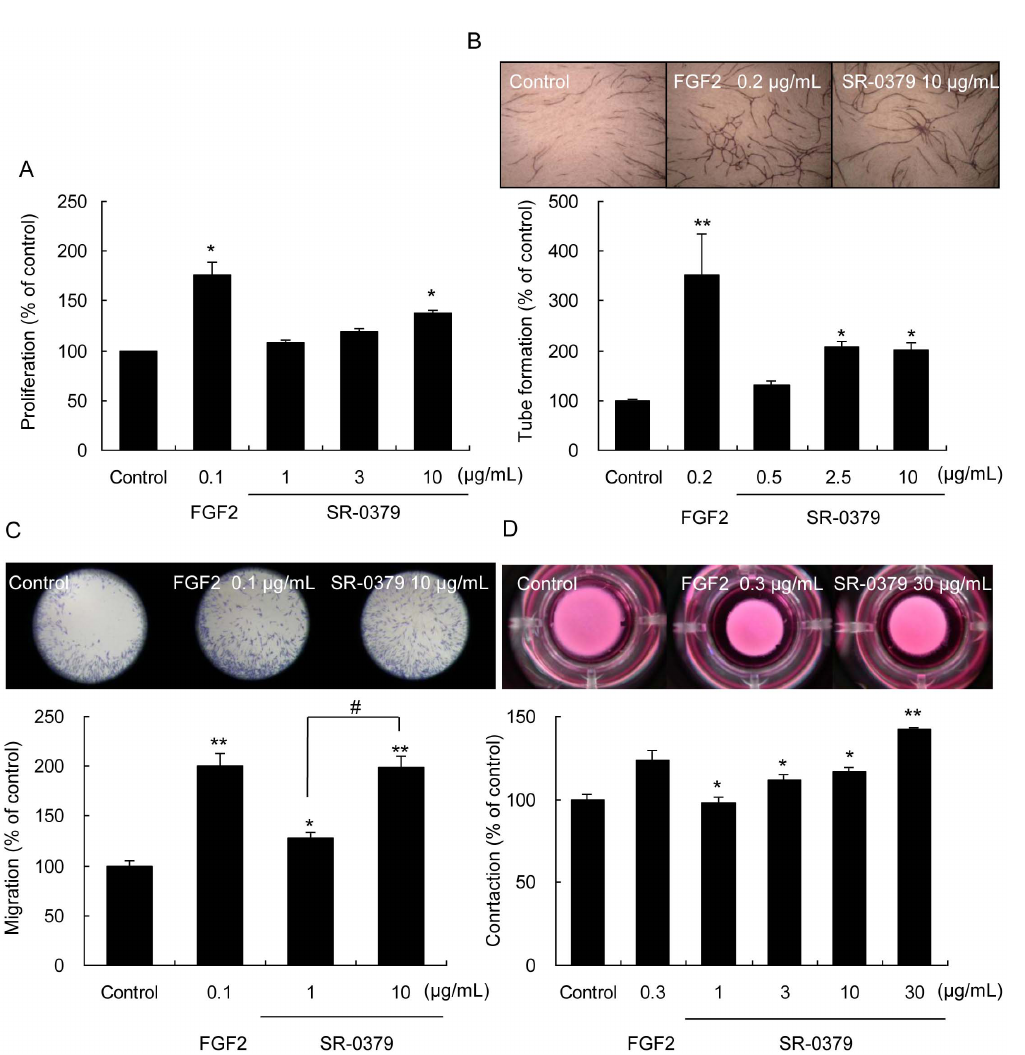
Figure 2. Cellular function of SR-0379. A) Effect of SR-0379 on NHDFs proliferation. NHDFs were treated with SR-0379 (1, 3 and 10 m g/ml) or FGF2 (0.1 m g/ml). N=4 per group. *P , 0.05 vs. control. B) The upper panel shows representative pictures of tube formation in a co-culture of HUVECs and NHDFs (Control, FGF2: 0.2 m g/ml) and SR-0379 (10 m g/ml). The lower panel shows the effects of SR-0379 on tube formation in a co-culture of HUVECs and NHDFs. N=5 per group. *P , 0.05, **P , 0.01 vs. control. C) The upper panel shows representative pictures of the migration induced by FGF2 (0.1 m g/ml) and SR-0379 (10 m g/ml). The lower panel shows the effects of FGF2 (0.1 m g/ml) and SR-0379 (1 and 10 m g/ml) on migration. N=4 per group. *P , 0.05, **P , 0.01 vs. control, # P , 0.01 vs. SR-0379 (1 m g/ml). D) The upper panel shows representative pictures of the fibroblast- collagen-matrix contraction assay with FGF2 (0.3 m g/ml) and SR-0379 (1, 3, 10 and 30 m g/ml). The lower panel shows the effects of FGF2 (0.3 m g/ml) and SR-0379 (1, 3, 10 and 30 m g/ml) on fibroblast-collagen matrix contraction. N=3 per group. *P , 0.05, **P , 0.01 vs. control.